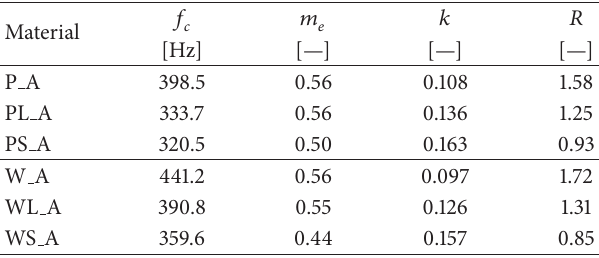
Table 5: Estimated parameters for 𝐺 ∗ master curves.